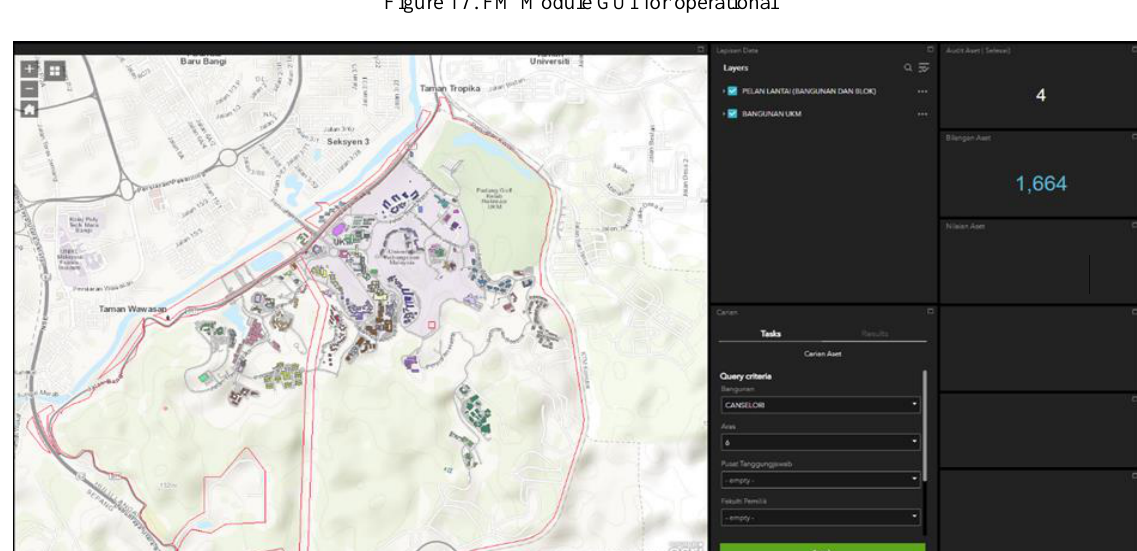
Figure 17. UKM FM Dashboard module GUI for operational and decision